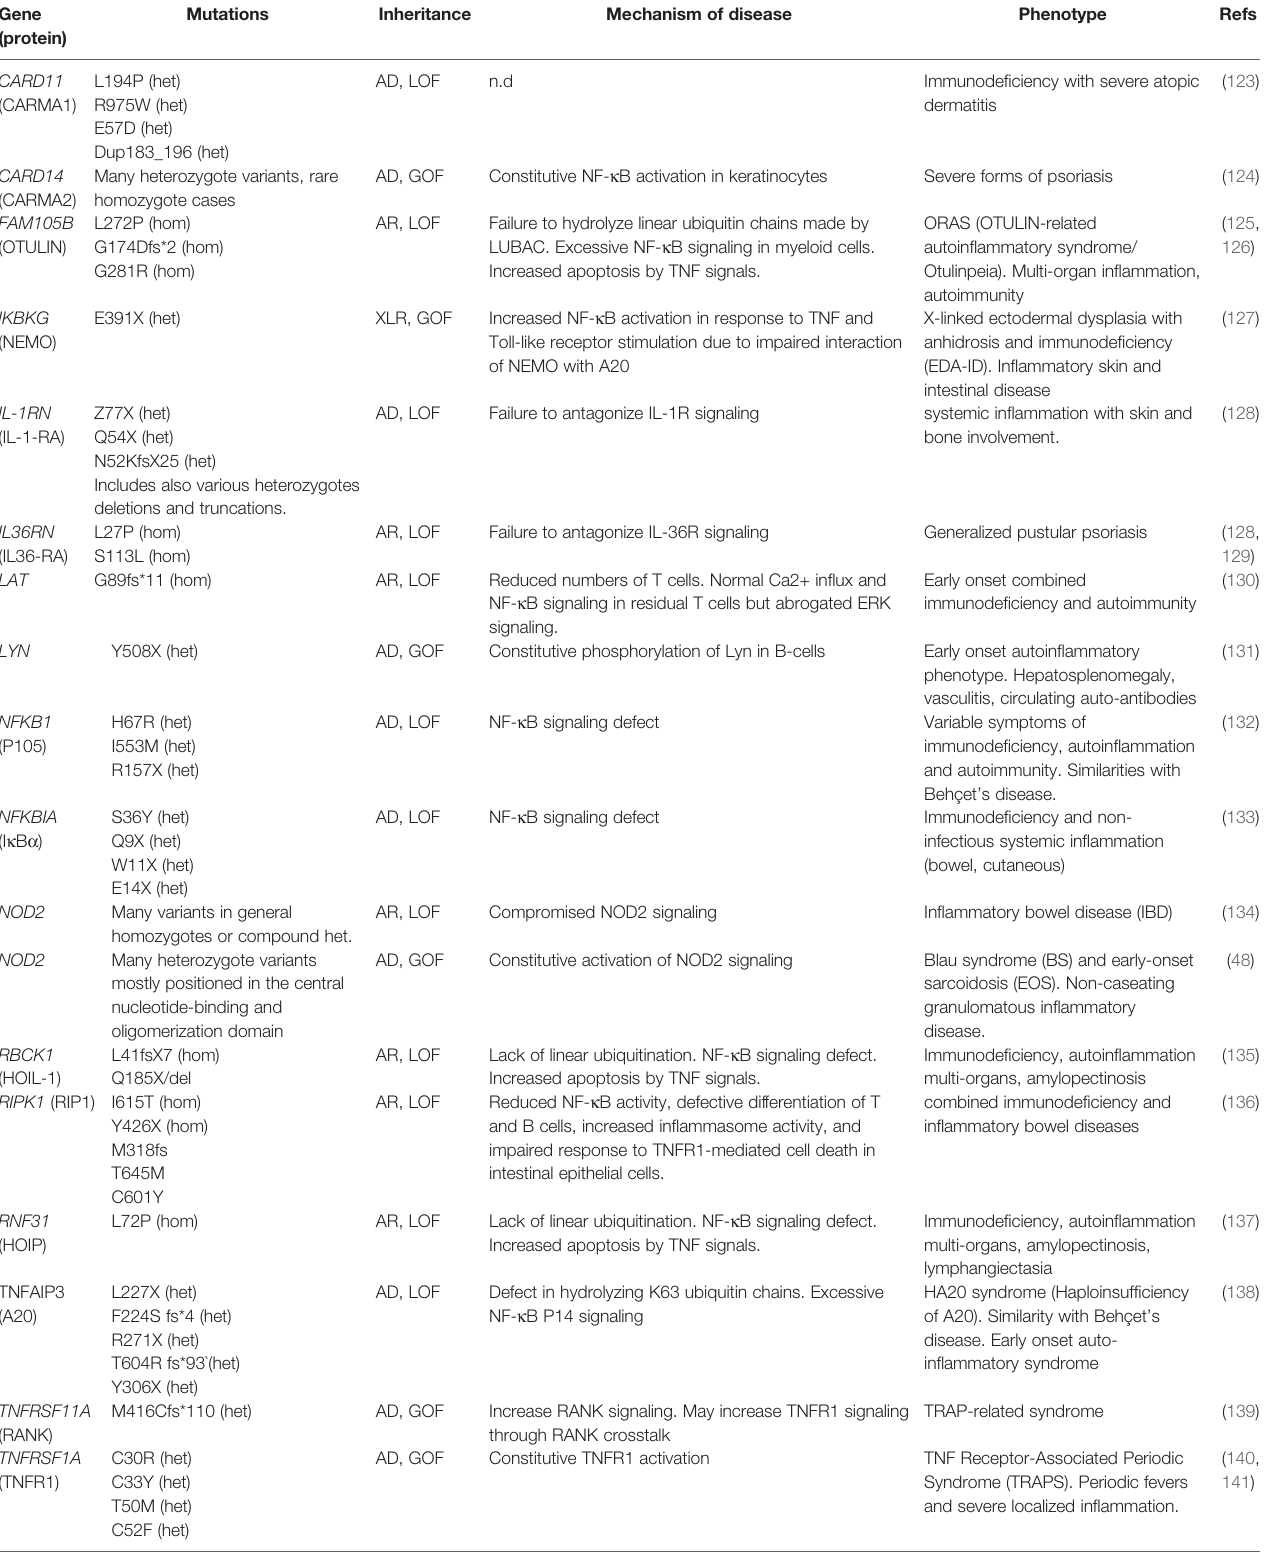
TABLE 1 | List of genes mutated in humans linking NF- k B to autoimmunity. Gene (protein)